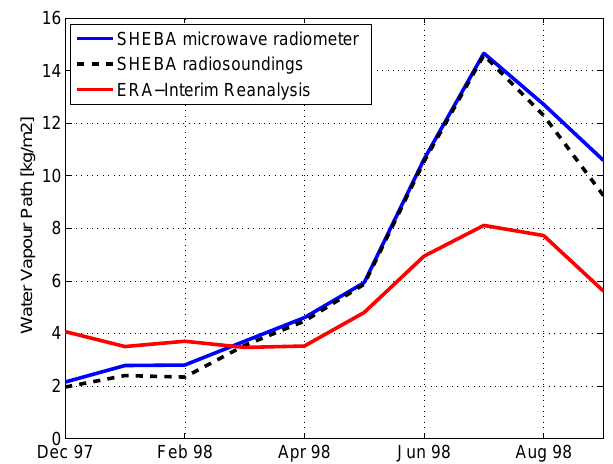
Fig. 6. Comparison of observed and ERA-Interim liquid water path with observations from a dual-channel microwave radiometer dur- ing the SHEBA campaign.